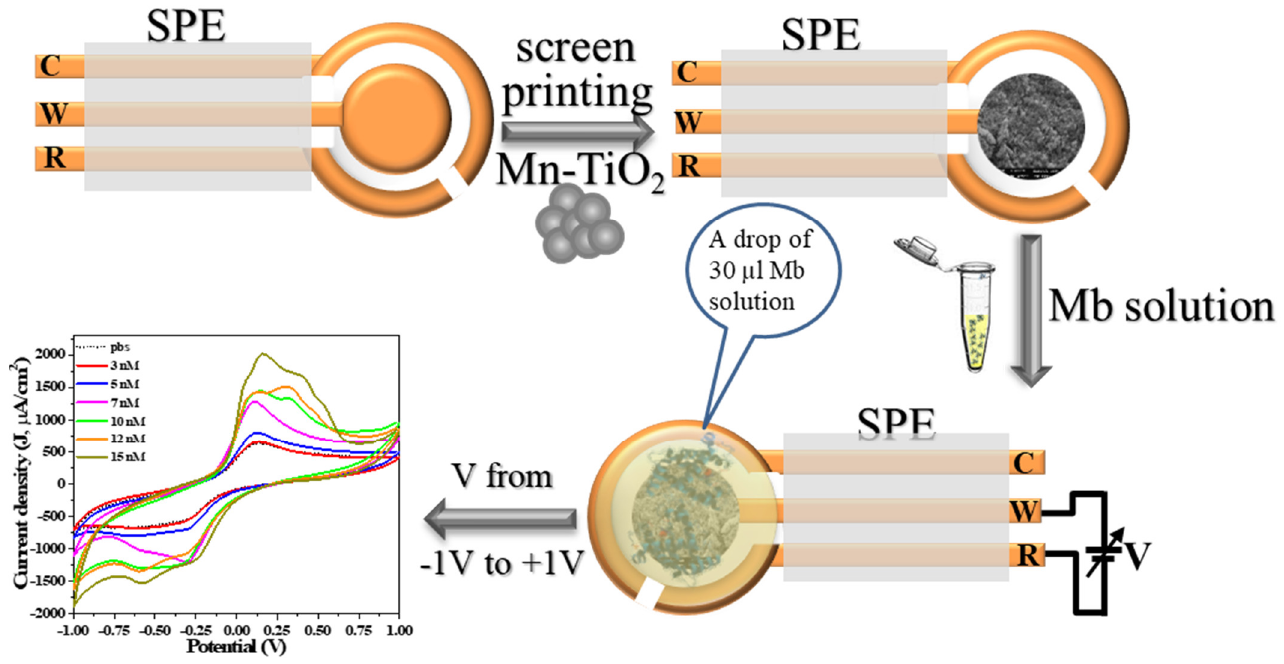
Figure 1. Process flow of electrochemical sensor fabrication and characterization.